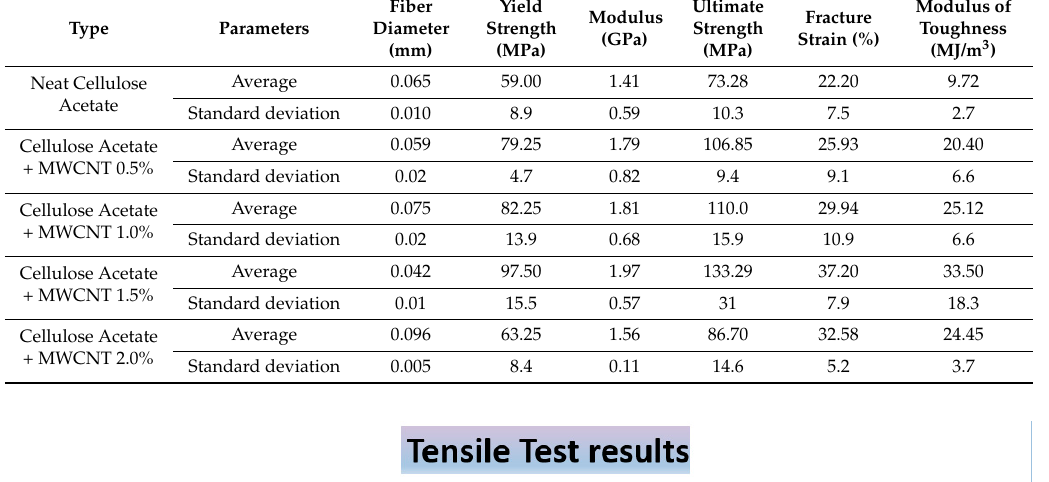
Table 1. Tensile test results.